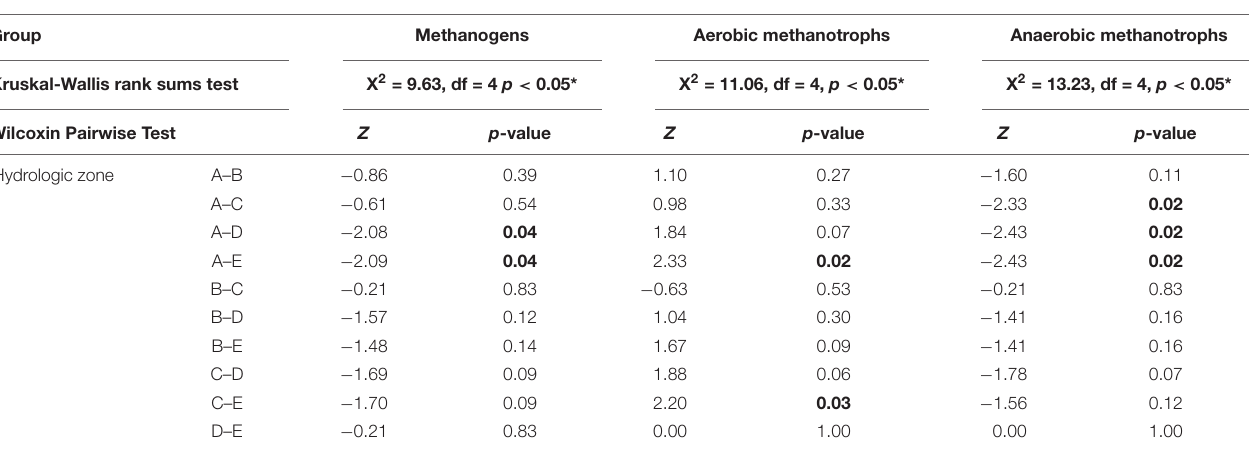
TABLE 4 | Comparisons of the methane cycling microbial community by hydrologic zone (A–E) . Methanogens Aerobic